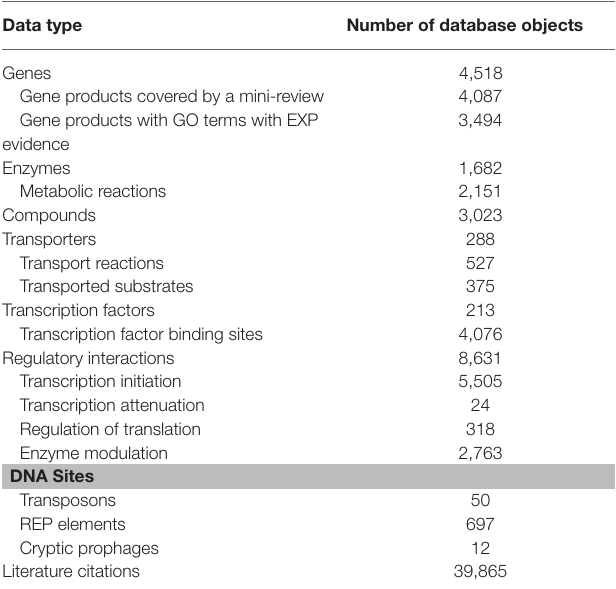
TABLE 1 | Select EcoCyc content and Escherichia coli gene product functions in release